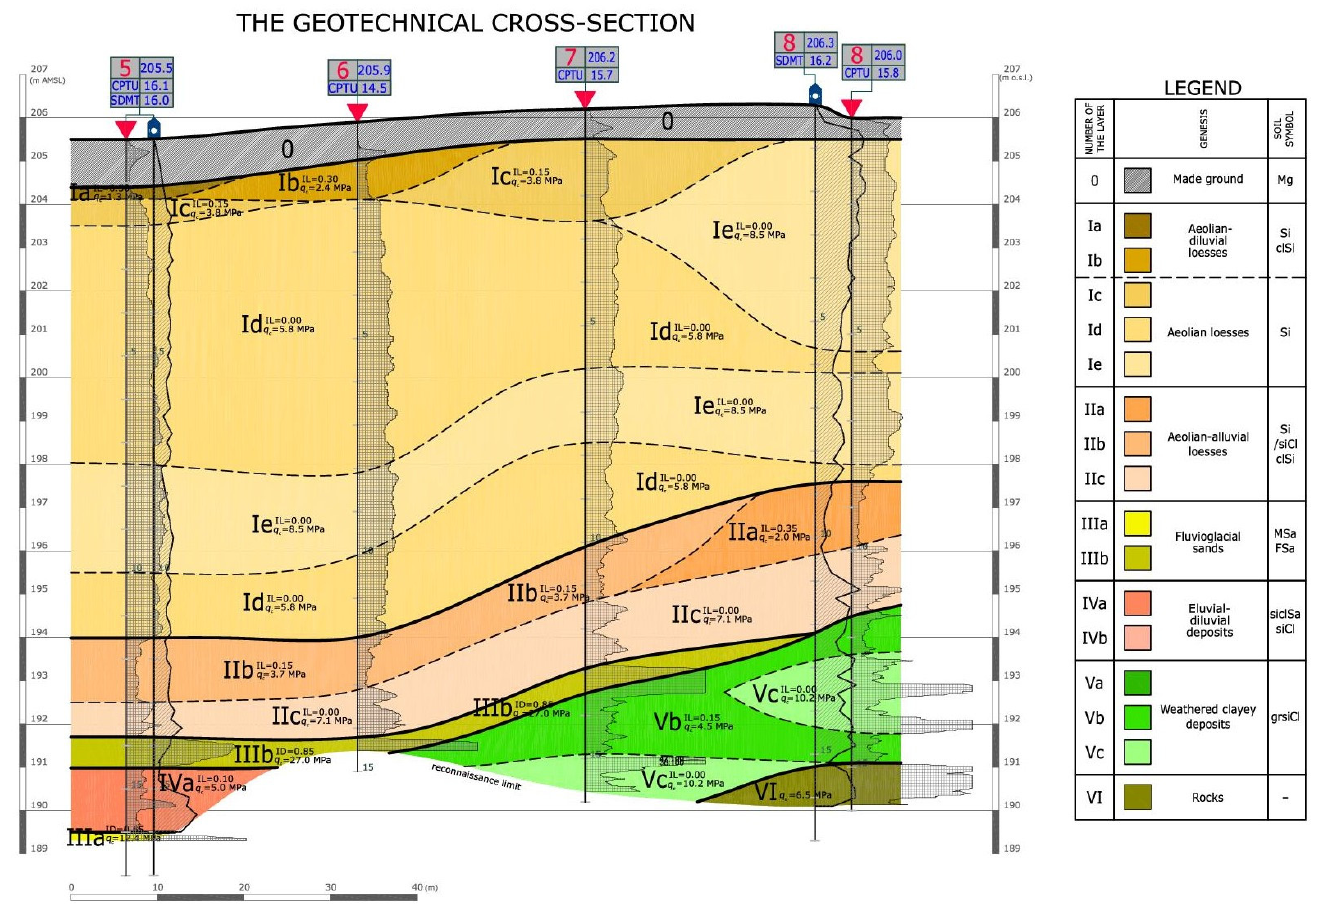
Figure 11. Geotechnical cross-section developed on the basis of CPTU soundings. SBT charts (e.g., Robertson’s chart) classify soils in terms of their behavior and are widely used to interpret the soil profile [20,38,45–47]. For aeolian loess soils, R f values most often range from 1.7 to 3.2%, which, with relatively high cone resistances q c , locates them in the area on the border between silty and sandy loess, and very often they are classified as sandy. Silt are soils classified on the border between cohesive and non-cohesive, and such soils are often referred to as “transitional”. SBT charts confirm that loess silt are transitional soils. Aeolian loess soils resemble non-cohesive deposits in their behavior, and the cohesion that occurs in them is largely the result of cementation with lime carbonate. Diluvial and alluvial loess soils are characterized by an increased content of clay fraction and are referred to as “clayey loess”. R f values in the range from 2.8 to 6.2% and lower q c values locate the soils of this facies within clayey silt and silty clay. Moreover, increased pore water pressure u 2 is observed within the alluvial